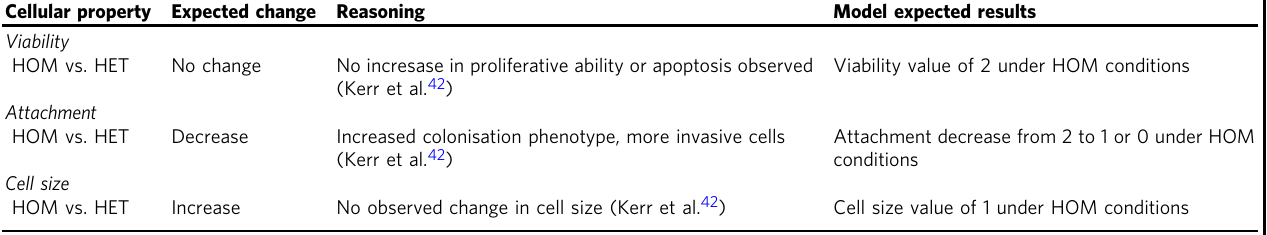
Table 4 Phenotype expression speci fi cation generated from gene arrays from MEFs Cellular property Expected change Reasoning Model expected